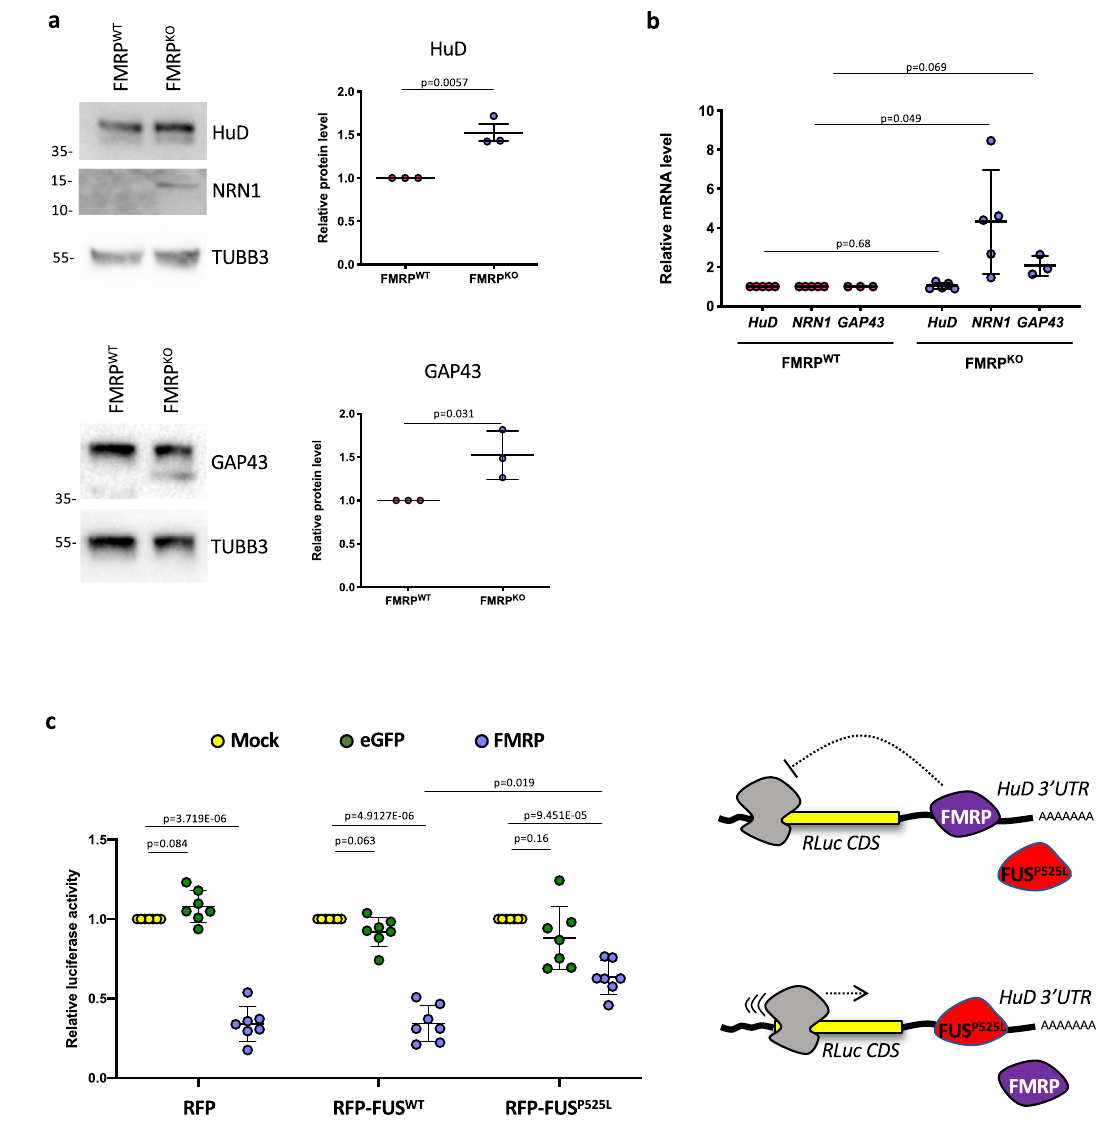
Fig. 3 FMRP is a post-transcriptional repressor of HuD expression. a Analysis of the protein levels of the indicated genes by western blot in FMRP WT and FMRP KO hiPSC-derived spinal MNs. The molecular weight (kDa) is indicated on the left. The graphs show the average from three independent differentiation experiments, error bars indicate the standard deviation (Student ’ s t -test; paired; two tails). TUBB3 signal was used for normalization. Protein levels are relative to FMRP WT conditions. b Analysis of the mRNA levels of the indicated genes by real-time qRT-PCR in FMRP WT and FMRP KO hiPSC- derived spinal MNs. For each experiment, values are shown as relative to the isogenic FMRP WT control, set to a value of 1. The graph shows the average from 3 to 5 independent differentiation experiments, error bars indicate the standard deviation (Student ’ s t -test; paired; two tails). c Luciferase assay in HeLa cells expressing RFP, RFP-FUS WT , or RFP-FUS P525L and transfected with the Renilla luciferase reporter construct containing the HuD 3 ′ UTR (RLuc- HuD 3 ′ UTR) alone (Mock) or in combination with plasmids overexpressing FMRP or eGFP as a control (Student ’ s t -test; paired; two tails). The drawing depicts the competition between mutant FUS and FMRP for HuD 3 ′ UTR binding and its effects on the reporter expression of HuD after induction of MN differentiation FUS WT MNs, a clear punctate signal was present in the FUS P525L (Supplementary Fig. 10a). The SYN1::HuD construct was stably mutant (Fig. 7d and Supplementary Fig. 7a). To a minor extent, integrated in FUS WT hiPSCs (FUS WT + HuD in Fig. 6a and in difference in GAP43 levels was also found in the MN soma (Supplementary Fig. 7b). Increase of HuD , NRN1 and GAP43 Supplementary Fig. 10b – e). As a control, we also generated a mRNA and protein levels was con fi rmed in MNs generated from FUS WT hiPSC line containing SYN1::RFP construct (FUS WT + RFP). These cells were then induced to differentiate to MNs. Rise two additional FUS P525L hiPSC lines 45 (Supplementary Figs. 8 and 9). of HuD in FUS WT SYN1::HuD MNs was in the range of HuD levels observed in FUS P525L MNs. In these cells, we observed increased levels of NRN1 and GAP43 mRNA compared to the parental FUS WT line, while no effect was observed in the FUS WT + RFP control (Fig. 6a). In the case of GAP43 , however, change in mRNA levels between FUS WT and FUS WT + HuD did not reach statistical signi fi cance. A stronger effect on NRN1 ,